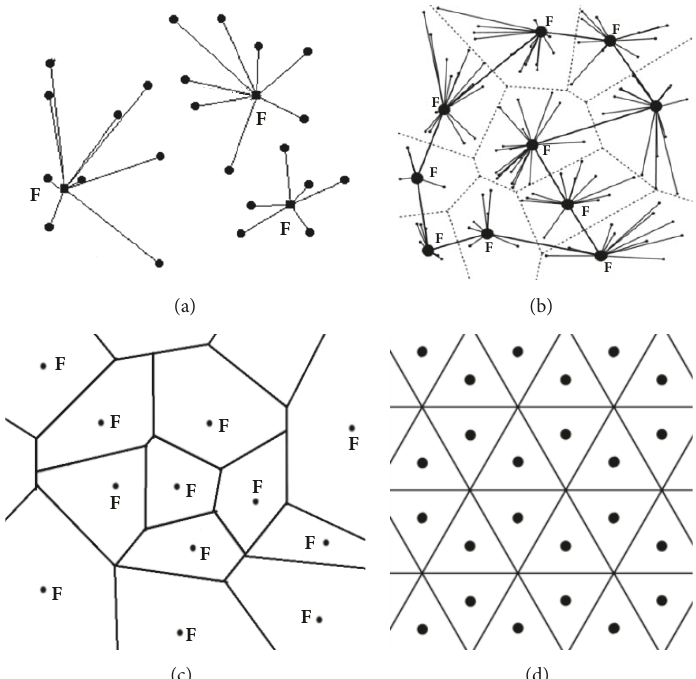
Figure 1: (a) Regular discrete location problem; (b) complicated discrete location problem; (c) regular continuous location problem; (d) stylized continuous location